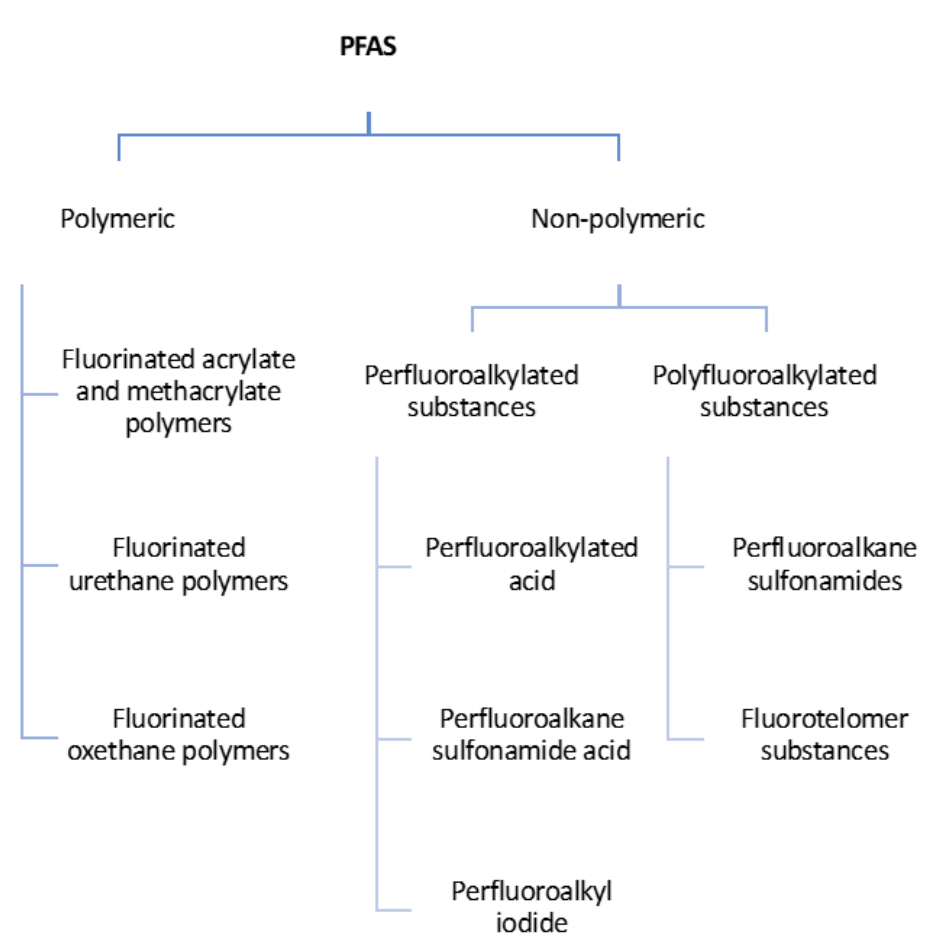
Figure 1. Classification of perfluoroalkylated and polyfluoroalkylated substances [2].